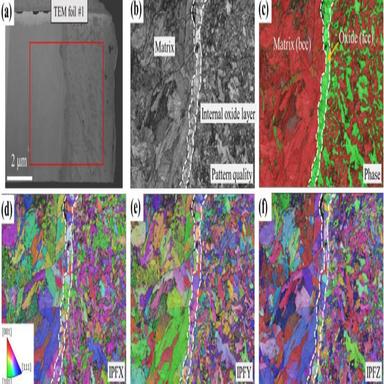
TKD analysis results at the matrix-internal oxide layer interface of T91 after exposure in SCW at 600 °C for 1500 h. (a) SEM image, (b) pattern quality map, (c) phase map and (d-f) IPF maps.